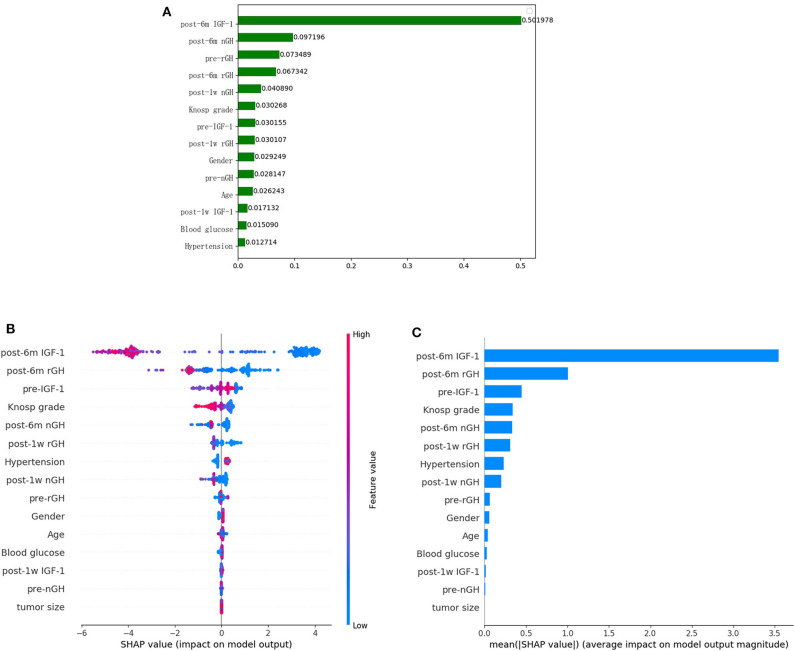
Feature importance ranking based on permutation importance (A) and SHapley Additive exPlanations (SHAP) values (B,C) in XGboost model. (A) The features are ranked based on the permutation importance method in the XGboost model. (B) The features are ranked according to the sum of the SHAP values for all patients, and the SHAP values are used to show the distribution of the effect of each feature on the XGboost model outputs. Red indicates that the value of a feature is high, and blue indicates that the value of a feature is low. The x-axis indicates the effect of SHAP values on the model output. The larger the value of the x-axis, the greater the probability of delayed remission. (C) Standard bar charts were drawn and sorted using the average absolute value of the shape values of each feature in the XGboost model.